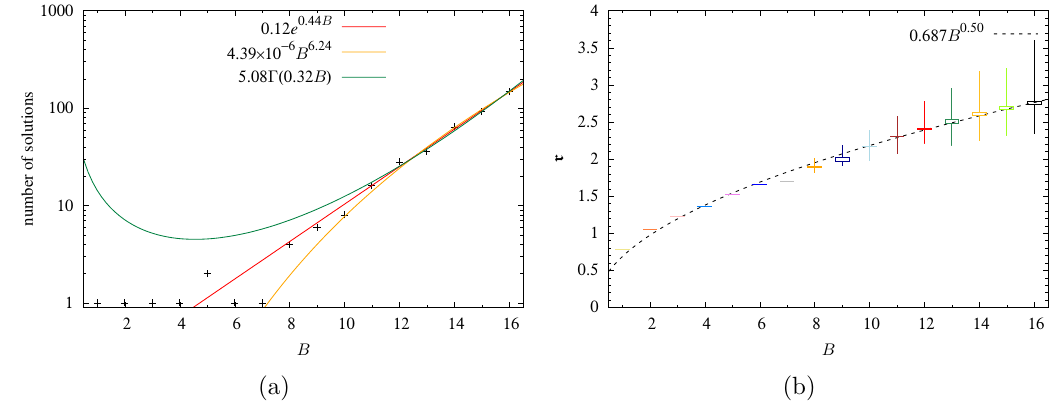
Figure 11. (a) Number of solutions as a function of B and (b) mean (upper edge of box) and median (lower edge of box) of radii for each B . The spread of the radius is shown with a solid line above and below the